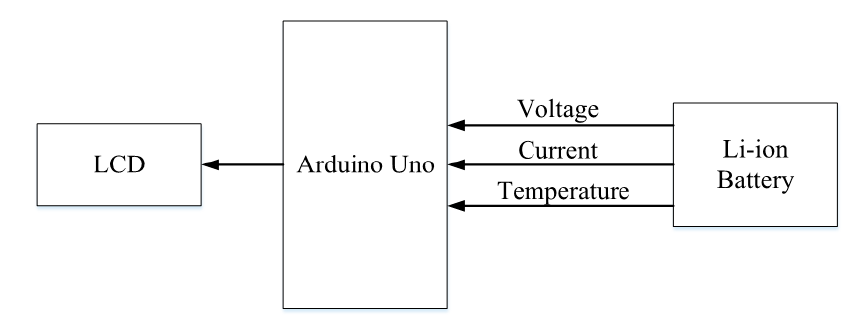
Figure 13. Configuration of the diagnosis system.